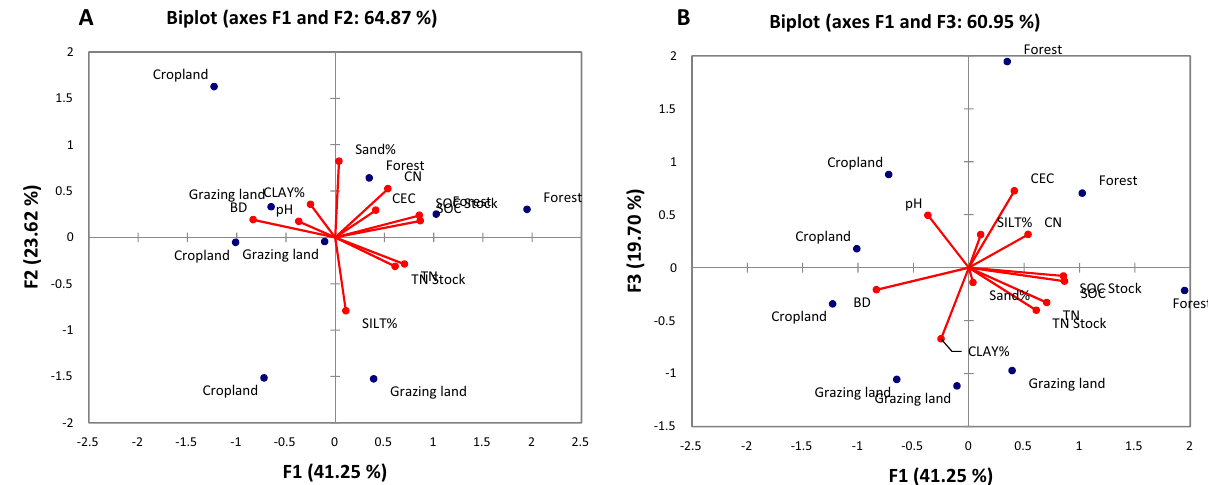
Figure 5. Biplots of Hugumburda depending on landuse indicating ( A ) Factor axis F1 and F2, and ( B ) Factor axis F1 and F3, as influenced by land use. Soil physico-chemical characteristics: BD = bulk density, Soil texture (sand%, silt% and clay%), SOC = soil organic carbon, TN = total nitrogen, CEC = cation exchange capacity, CN = C:N ratio. The red arrow denotes the direction of the high weighting of soil physico-chemical characteristics in the first (FA-1) and second factor